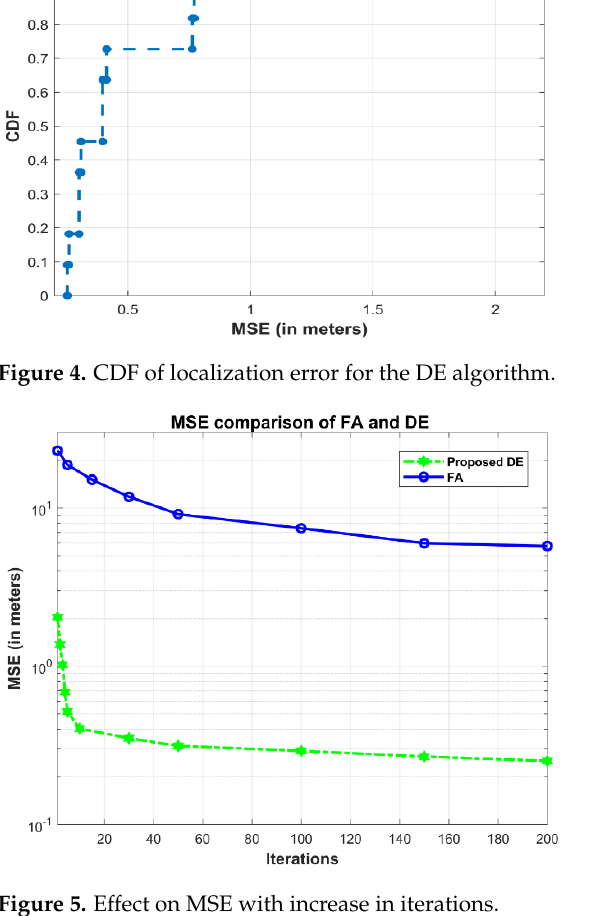
Figure 4. CDF of localization error for the DE algorithm.